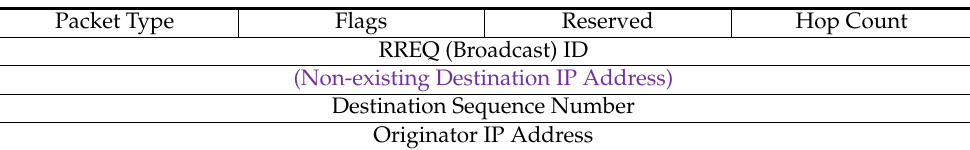
Table 4. The format of a forged RREQ